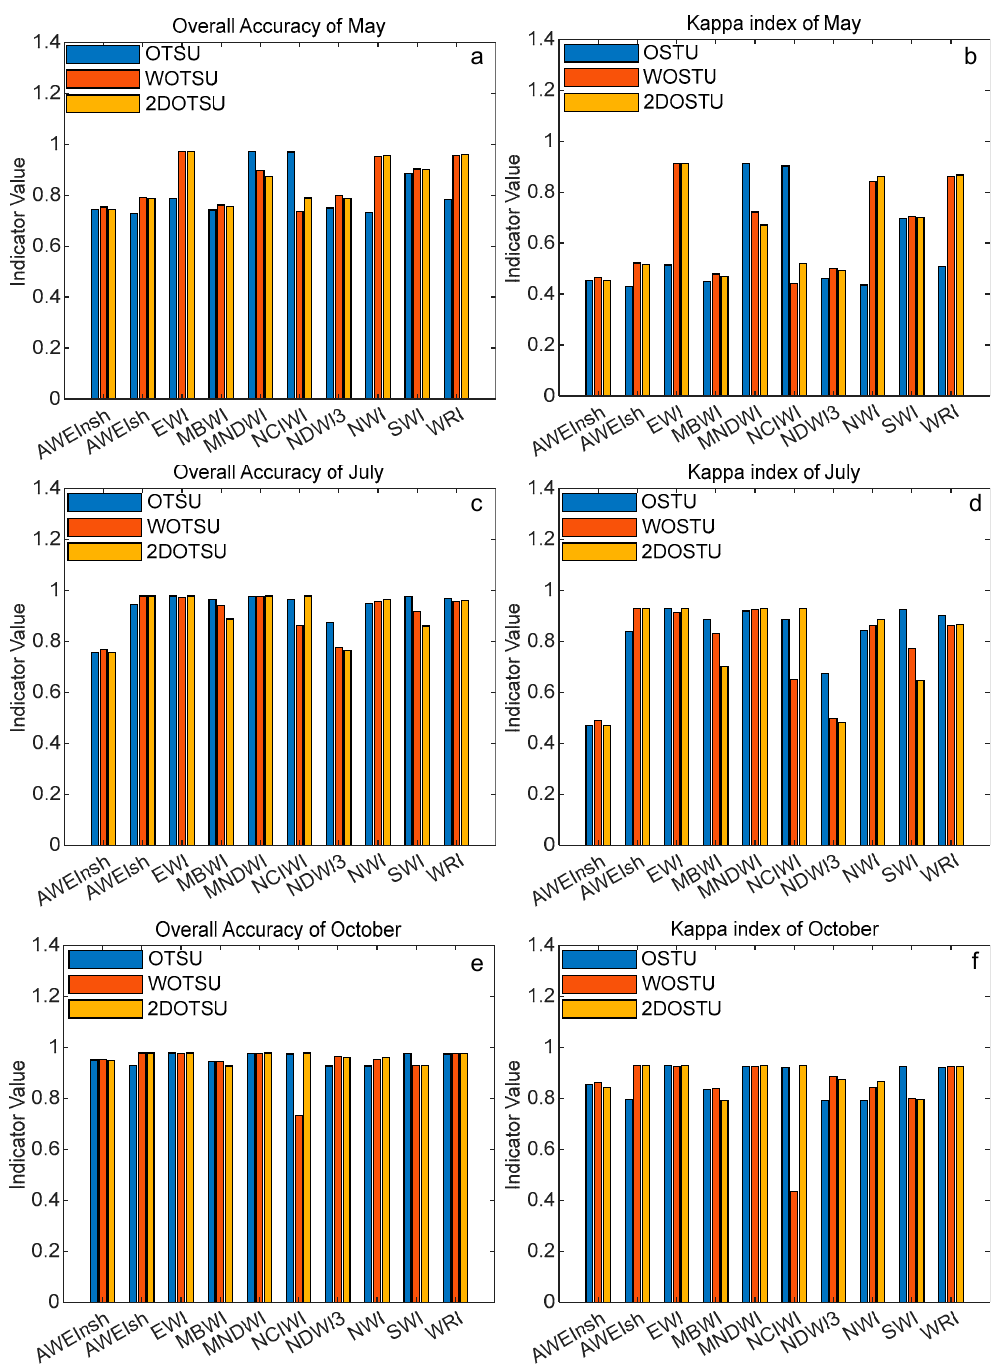
Figure 8. Evaluation charts of OA ( a , c , e ) and Ka ( b , d , f ) of water extraction experiments for water indices of different water periods based on the optimal segmentation thresholds obtained by the three adaptive algorithms in the study area of Chagan Lake.